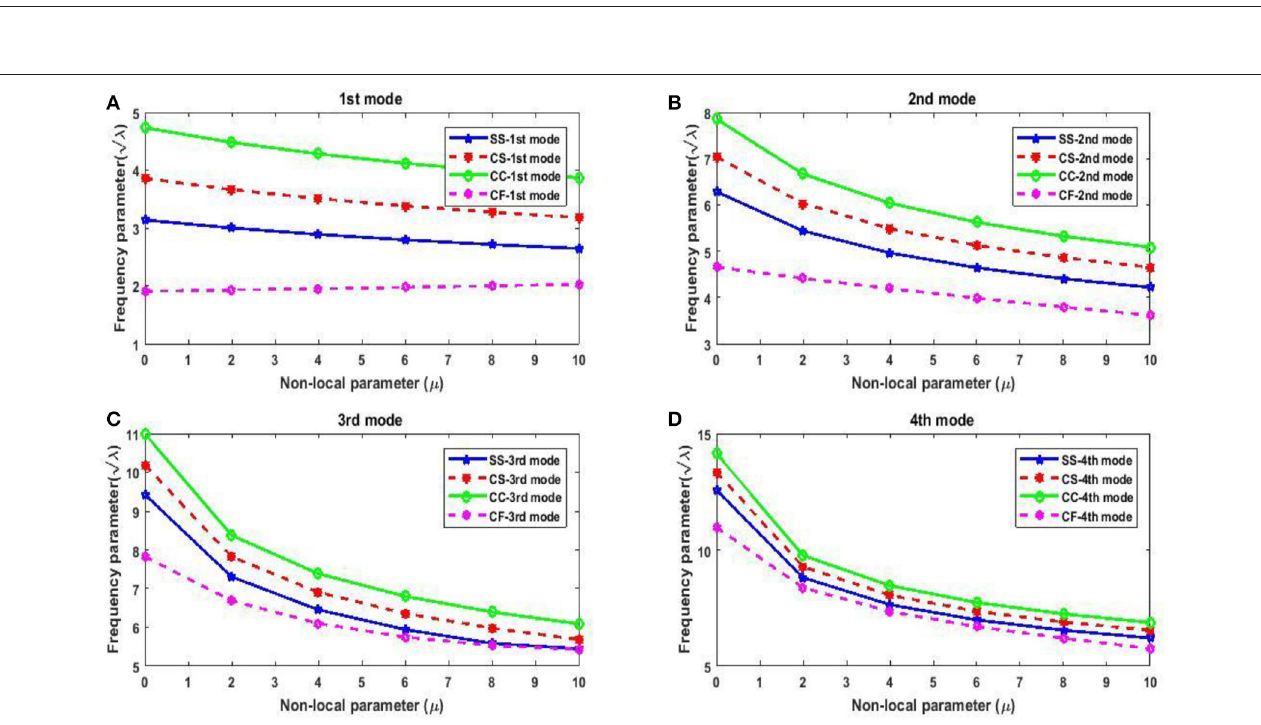
FIGURE 5 | Variation of frequency parameter with boundary condition. (A) Variation of boundary condition for 1st mode. (B) Variation of boundary condition for 2nd mode. (C) Variation of boundary condition for 3rd mode. (D) Variation of boundary condition for 4th mode.